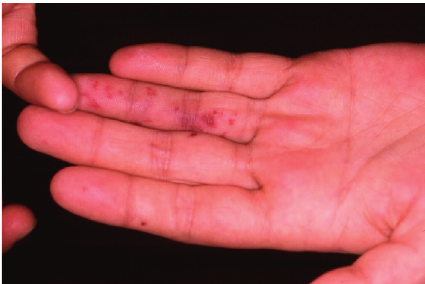
Figure 3: Janeway lesions: erythematous macular painless rashes distributed along the tips of the